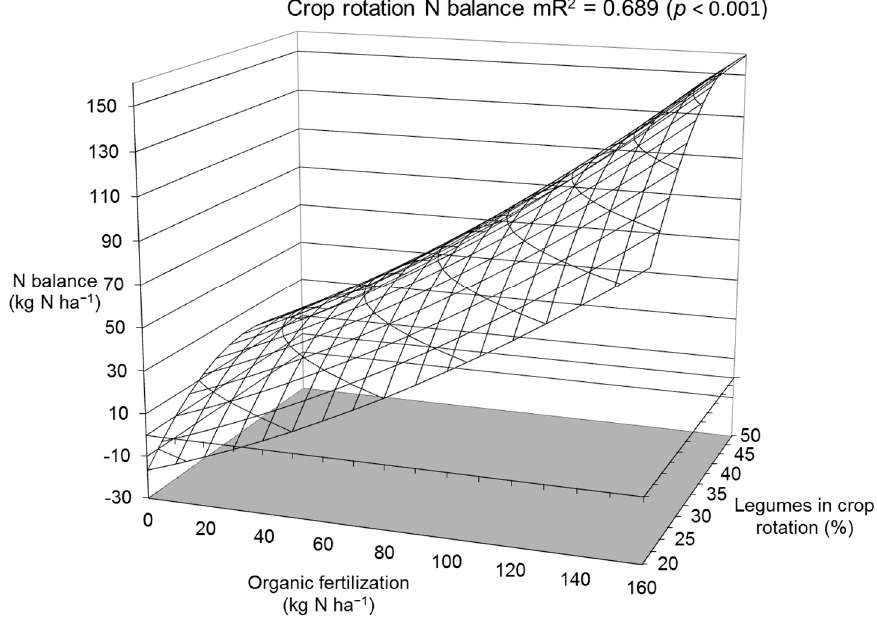
Figure 9. Effects of increasing organic N fertilization and legume proportions in crop rotations on the N balances of crop rotations on heavy soils . N balances of crop rotations on heavy